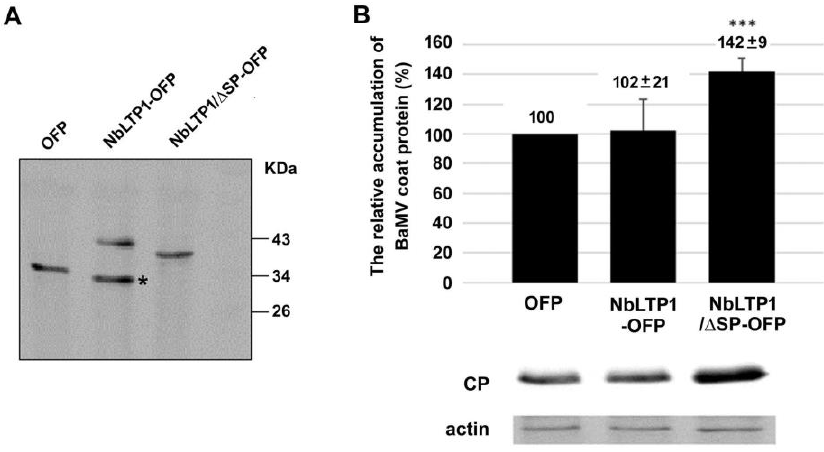
Figure 4. The relative accumulation of NbLTP1-OFP and NbLTP1 / ∆ SP-OFP in N. benthamiana . ( A ) Western blot analysis of the expression of NbLTP1-OFP and NbLTP1 / ∆ SP-OFP in N. benthamiana leaves. The degraded product derived from NbLTP1-OFP secreted to the extracellular space is labeled * on the blot. ( B ) The relative accumulation of BaMV CP in OFP, NbLTP1-OFP, and NbLTP1 / ∆ SP-OFP transiently expressed leaves. The accumulation of BaMV in OFP-expressed leaves was set to 100%. Data are mean ± SE relative levels from at least three independent experiments. *** p < 0.001 by a Student’s t -test.